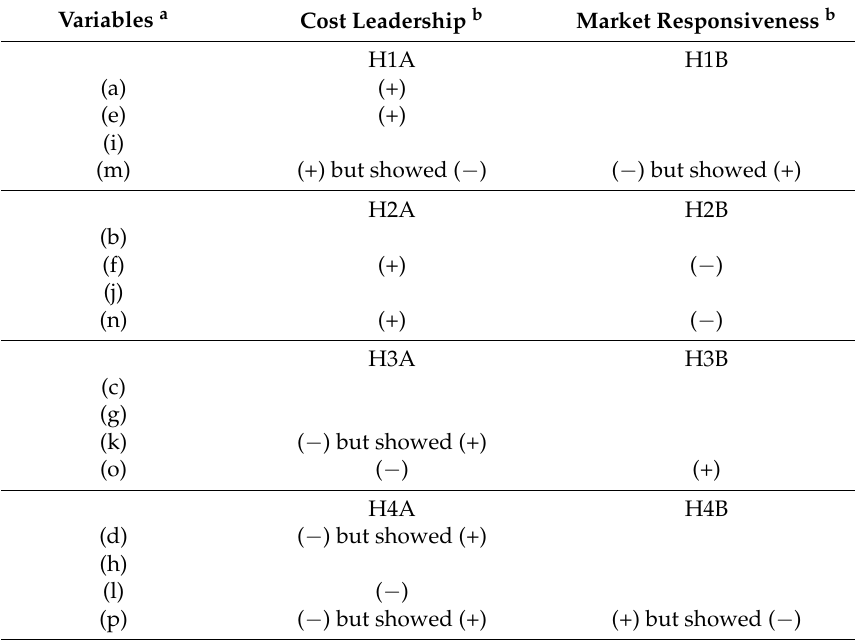
Table 8. Summary of statistically significant